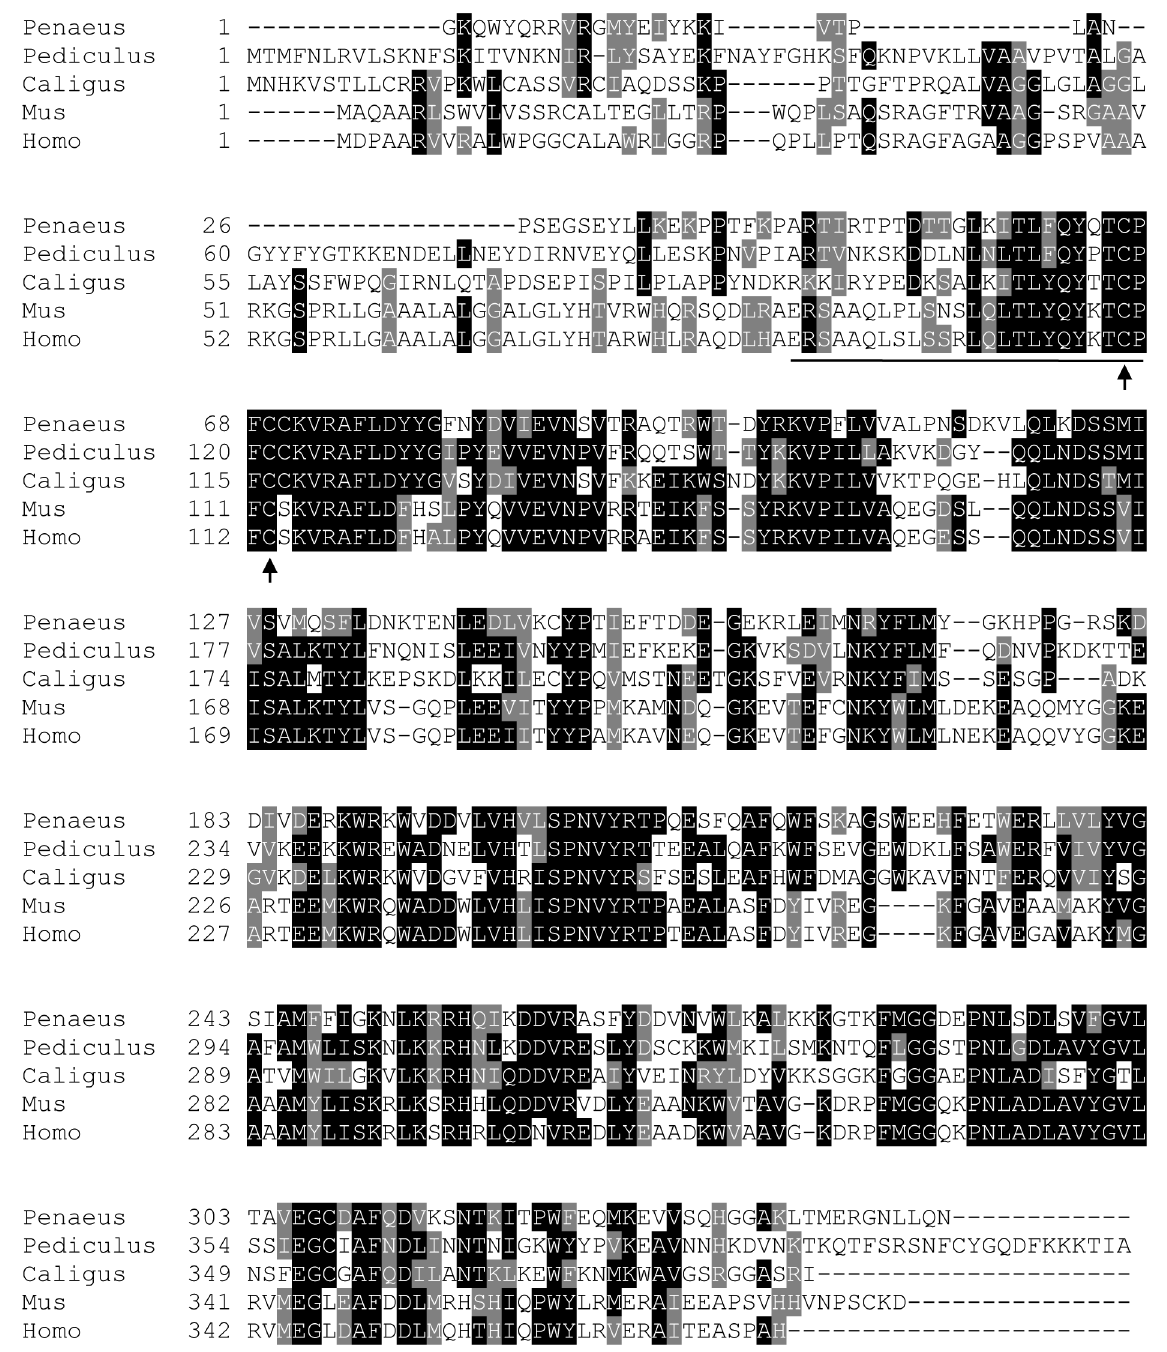
Figure 2. Mapping of essential residues in the predicted P. monodon PGES2 enzyme. Multiple sequence alignments of P. monodon PGES2 protein and their homologs were performed, revealing conserved Cys residues at the active site (black arrows) and the N-terminal sequence of the mature enzyme (underline). Genus and species used in this alignment are abbreviated as followed: Penaeus − P. monodon , Pediculus − P. humanus corporis , Caligus − Caligus rogercresseyi , Mus − Mus musculus and Homo − H. sapiens .